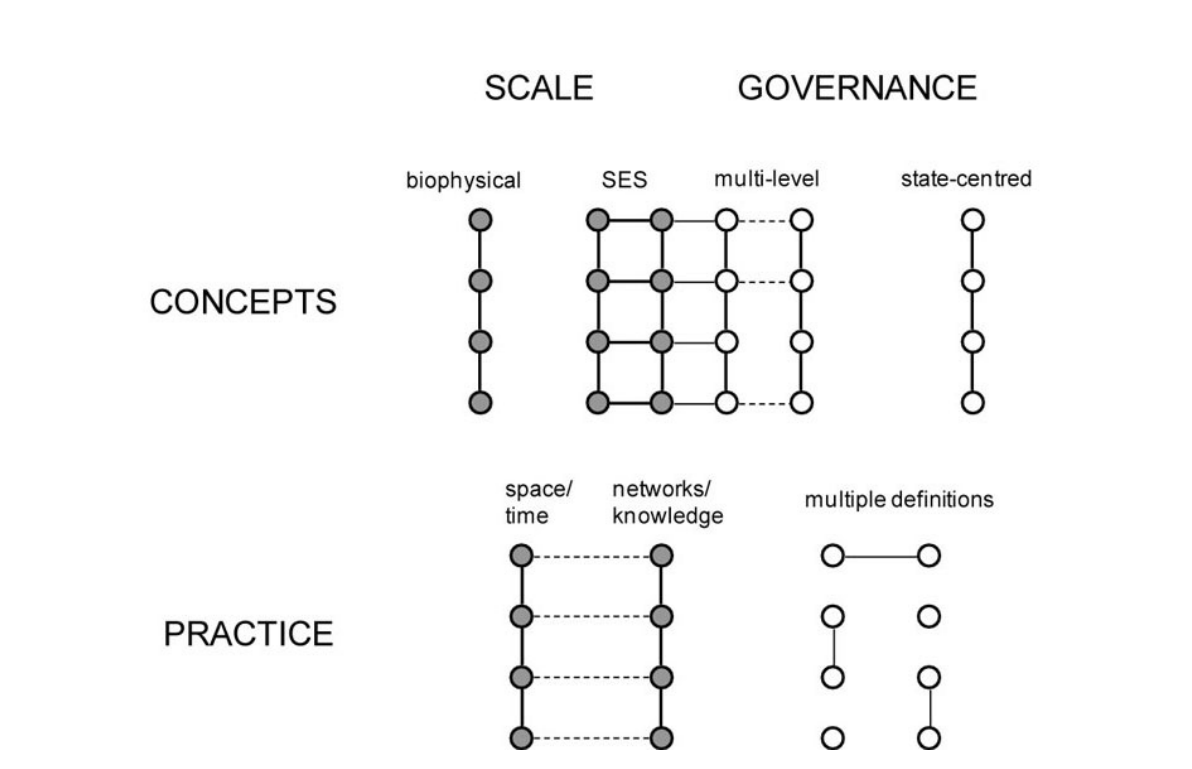
Fig. 1. Schematic illustration of conceptual shifts and practical implications related to the concepts of scale and governance and their interactions. White circles relate to levels of governance; grey circles to levels of